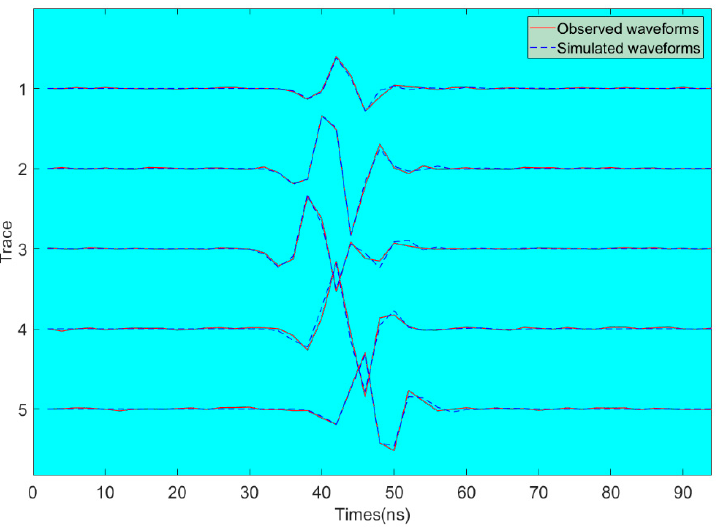
Figure 7. Five waveform traces. Blue dotted curves: simulated waveforms calculated on a posteriori model. Red curves: the observed waveform data.